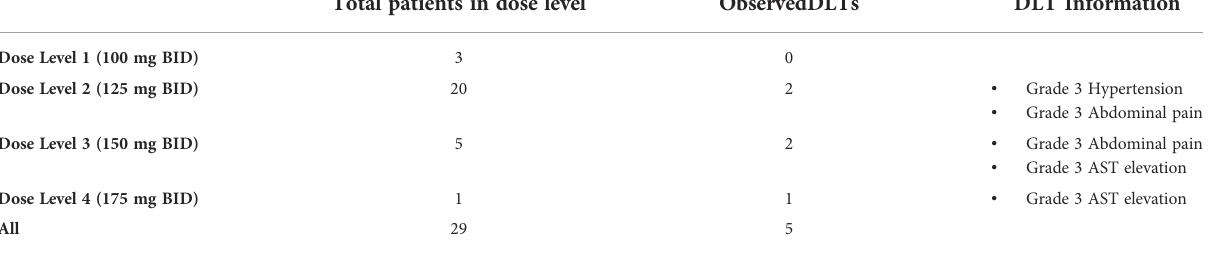
Figure 2. Serum concentrations of selumetinib and its